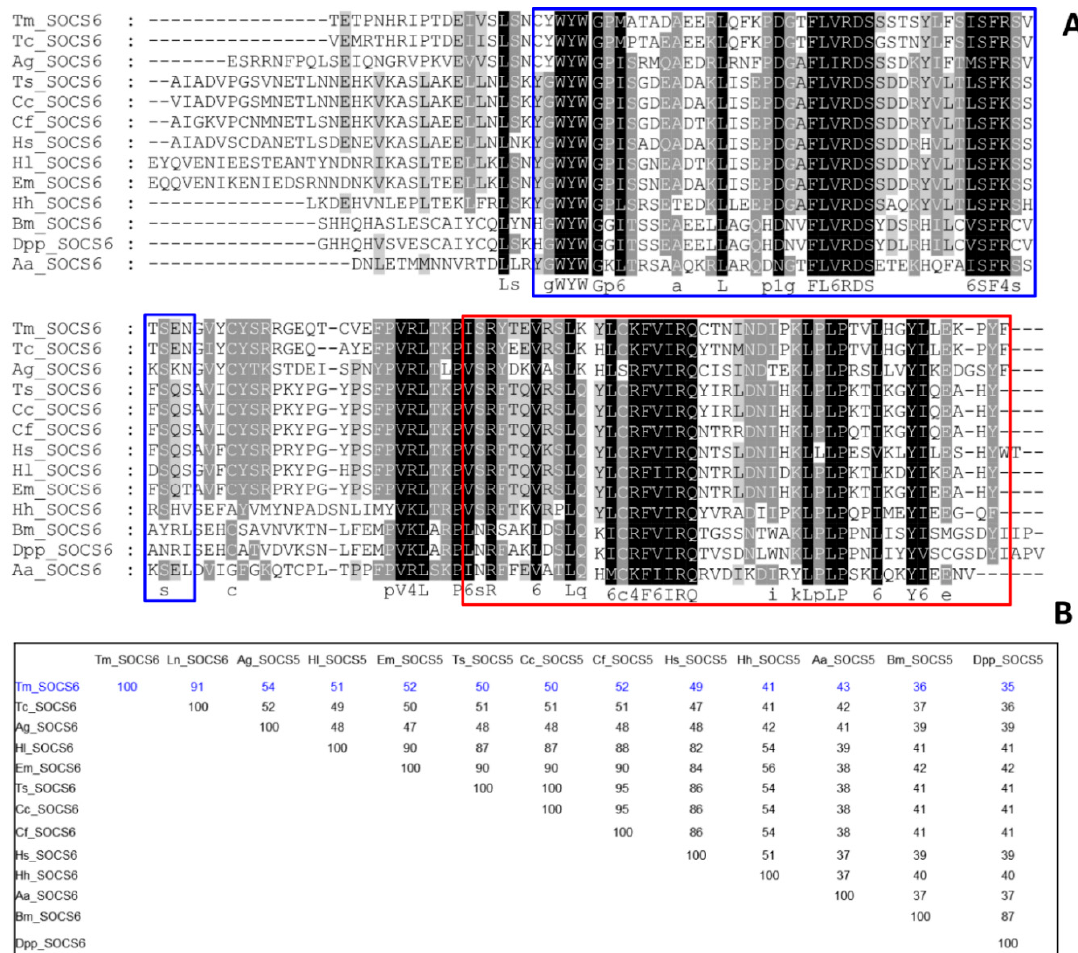
Figure 5. Alignment of TmSOCS6 to other SOCS6 proteins and percent identity: ( A ) Multiple sequence alignment of insect SOCS6 to insect proteins. Only the C-terminal region was conserved. SH2 and SOCS box domains are shown in blue and red boxes, respectively. Identical residues in all sequences are shaded black, and similar sequences are shaded grey. Deletions are indicated by dashes; ( B ) Percent identity matrix of SOCS6 members from representative insect species. Analysis was performed by clustalX2 using representative amino acid sequences from Tribolium castaneum (XP_008190646.1), Anopheles gambiae (JAB61954.1), Trachymyrmex septentrionalis (KYN39913.1), Ceratitis capitata (KYN07884.1), Camponotus floridanus (EFN74396.1), Harpegnathos saltator (EFN81362.1), Habropoda laboriosa (KOC63154.1), Eufrisea mexicana (OAD52403), Halyomorpha halys (XP_014279265.1), Bombyx mori (NP_001185652.1), Danaus plexippus plexippus (OWR49085.1), Aedes aegypti (XP_001660156.3).